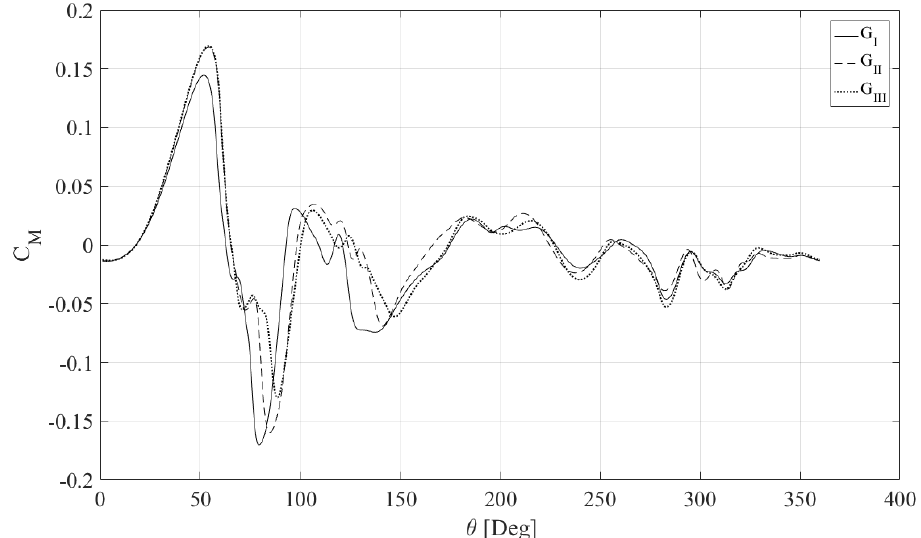
Figure 12. Spatial